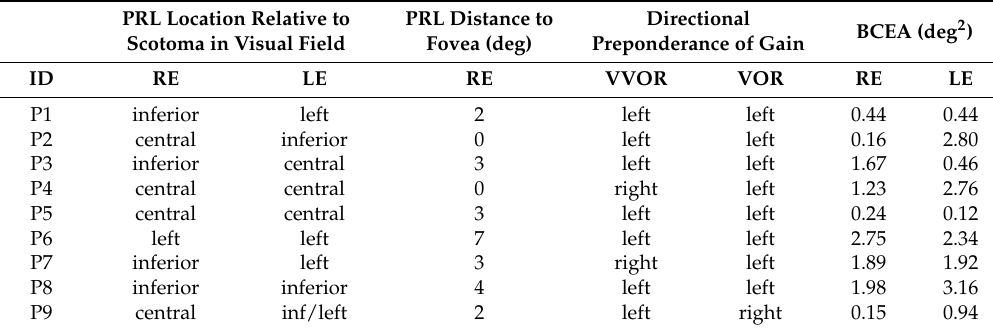
Figure 3. For the AMD (solid lines) and control groups (dashed lines), VVOR and VOR gain derived from the peak velocity of leftward and rightward eye movements between saccades. Error bars are ± 1 SE. Table 3. PRL characteristics of the participants with